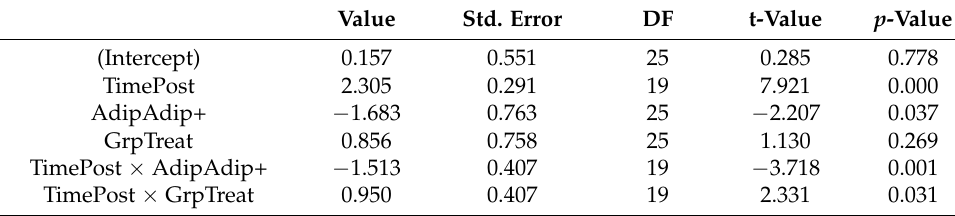
Table 7. LME parameters fitted to the trunk strength score (PC1, TS) of Study B.